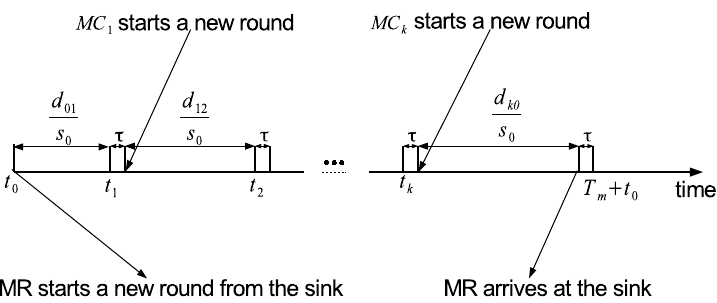
Figure 3. Cooperative movement time